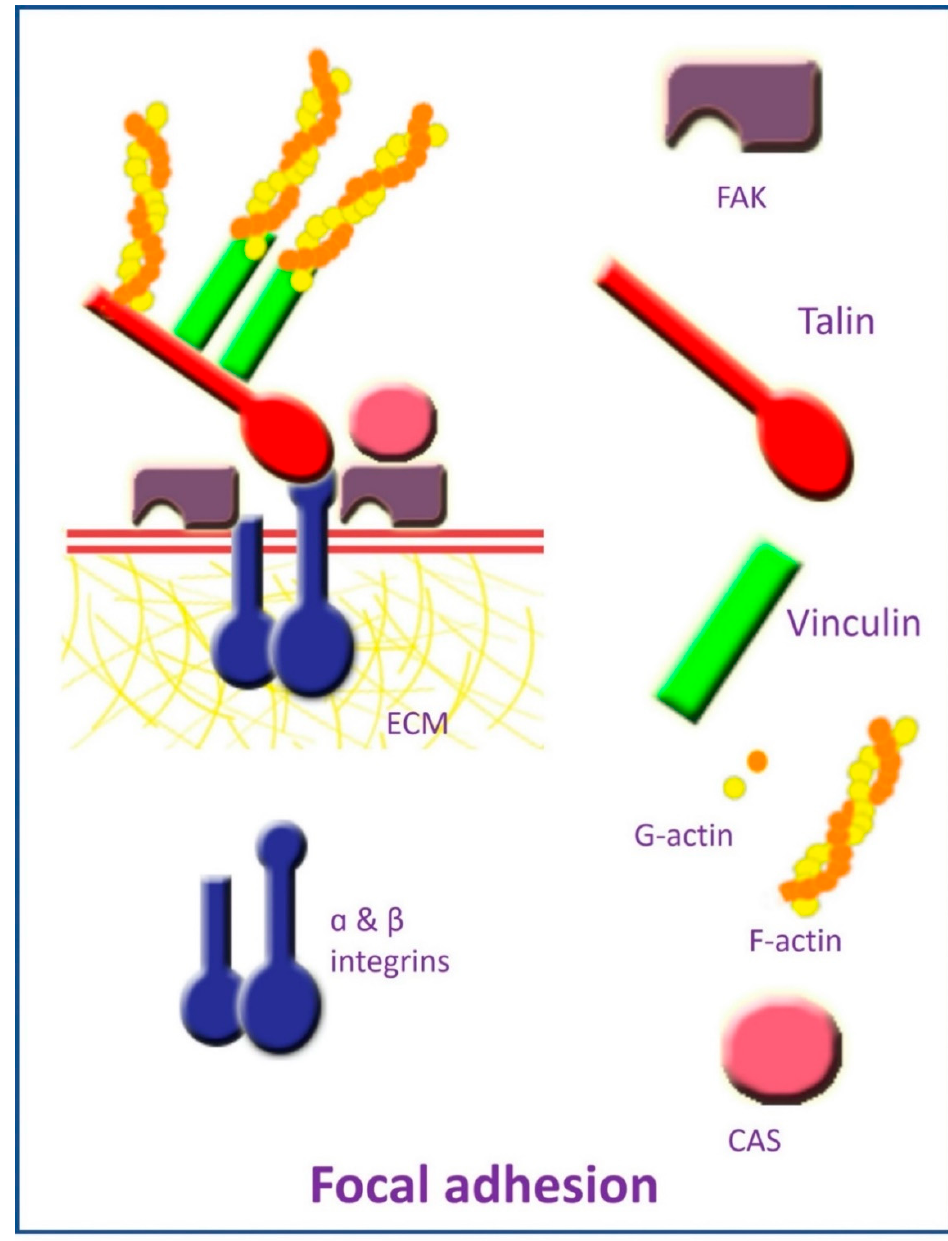
Figure 1. Elements of focal adhesion. Integrins are alpha and beta subunits heterodimers existing in different